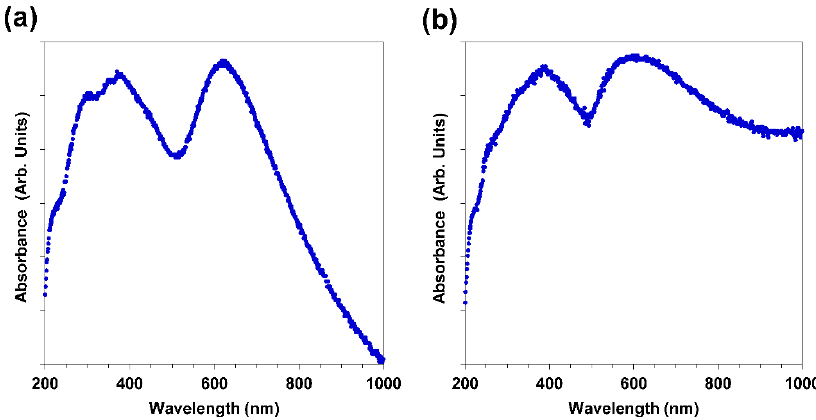
Figure 5. UV-VIS spectra of ( a ) Au-Cu nanofoams; and ( b ) Au-Cu-Pd macrobeams.